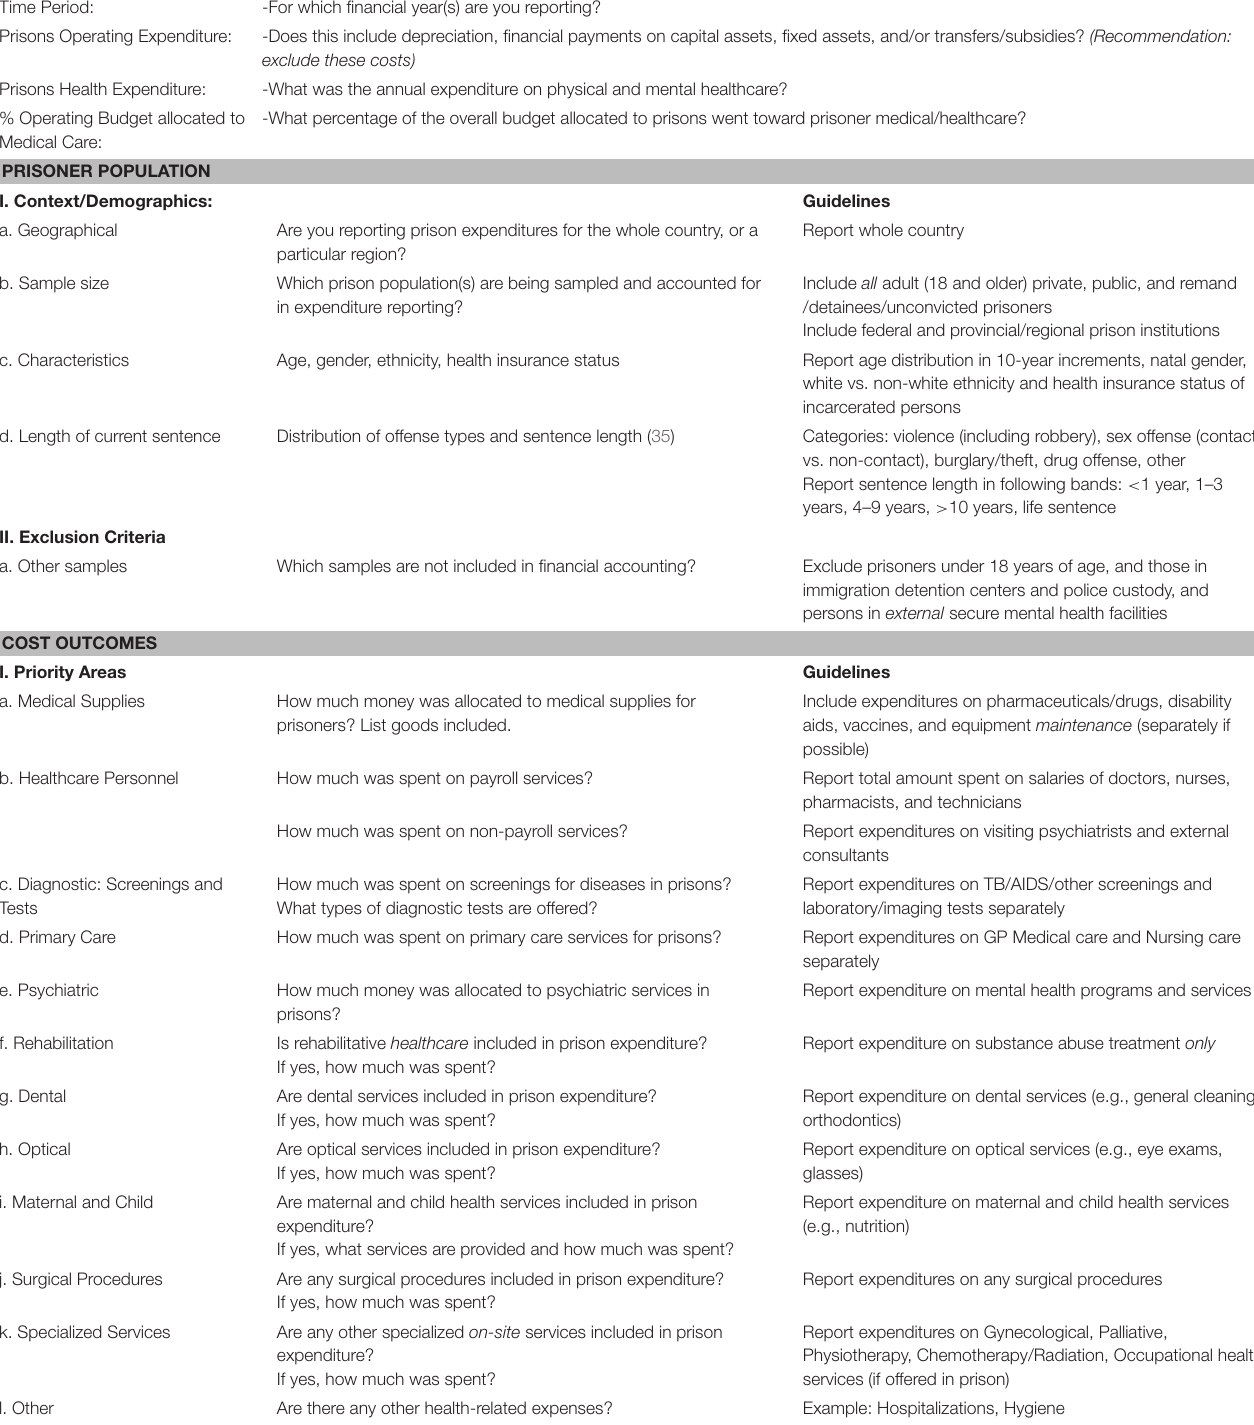
TABLE 6 | Prison healthcare expenditure reporting checklist.